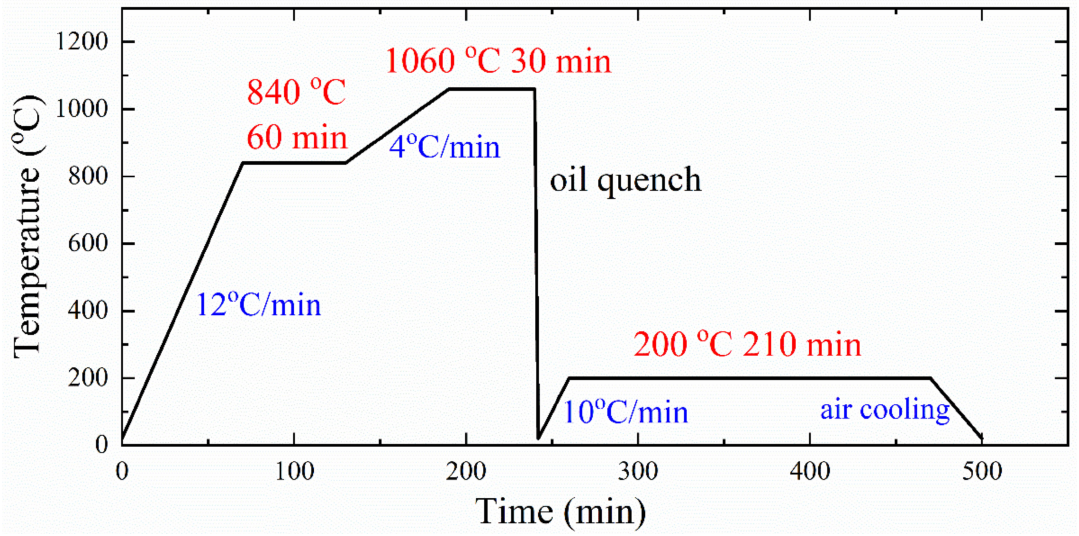
Figure 1. Heat treatment processes for the blade steels.